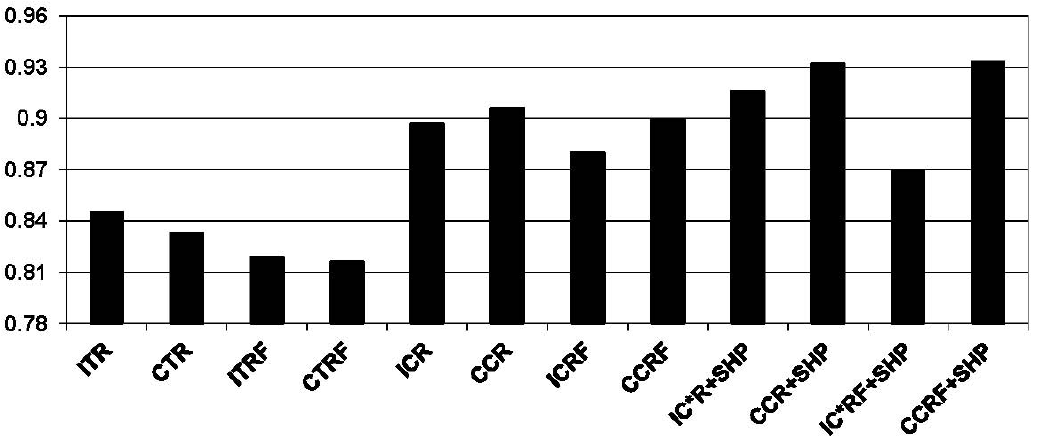
Figure 7. Global efficiency of heating